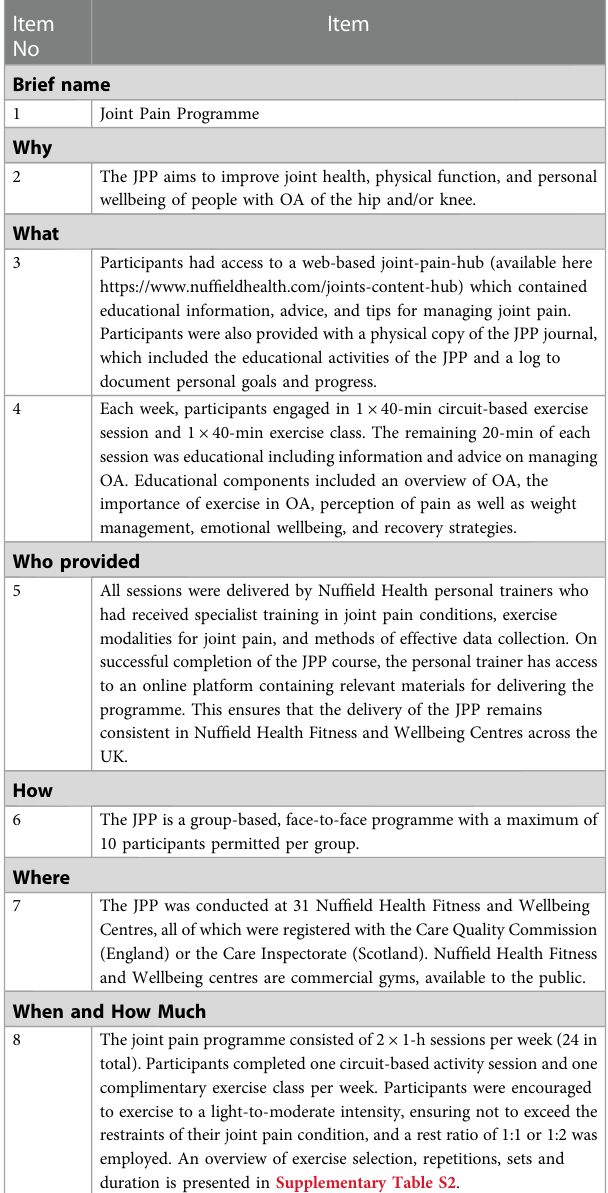
TABLE 2 Overview of joint pain programme according to the TIDieR